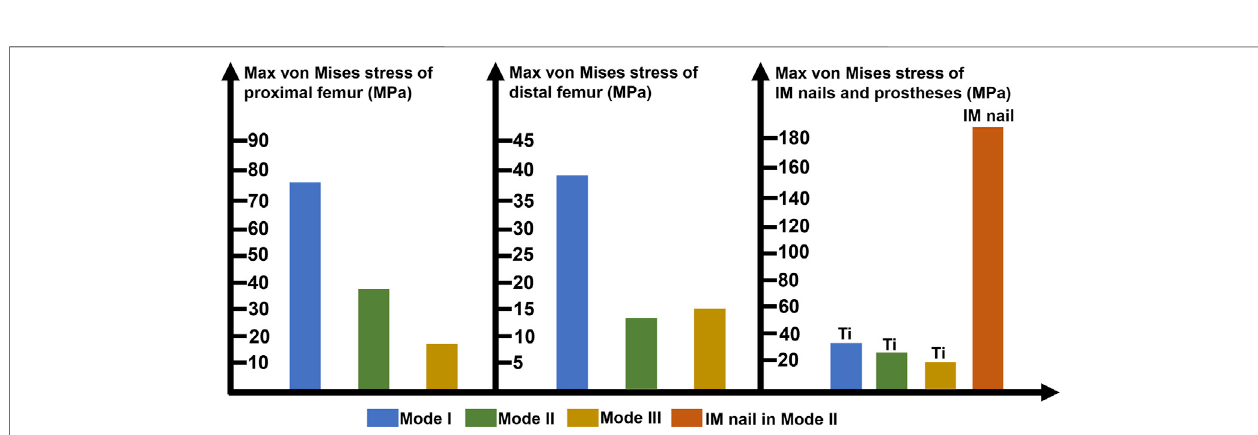
FIGURE 6 | Diagram of the maximum von Mises stress of proximal femur, distal femur, prostheses and intramedullary (IM) nail (Ti: 3D printed Ti6Al4V prosthesis).